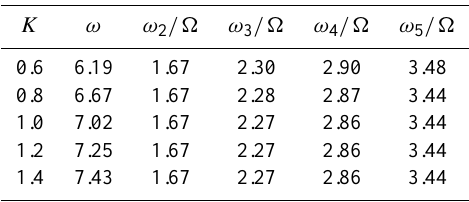
Table 2. Dependence of the resonator eigenfrequencies on factor K in Eq. (20).